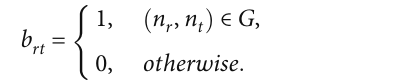
e ffi ciency of social products directly a ff ects the e ffi ciency of people and even the whole